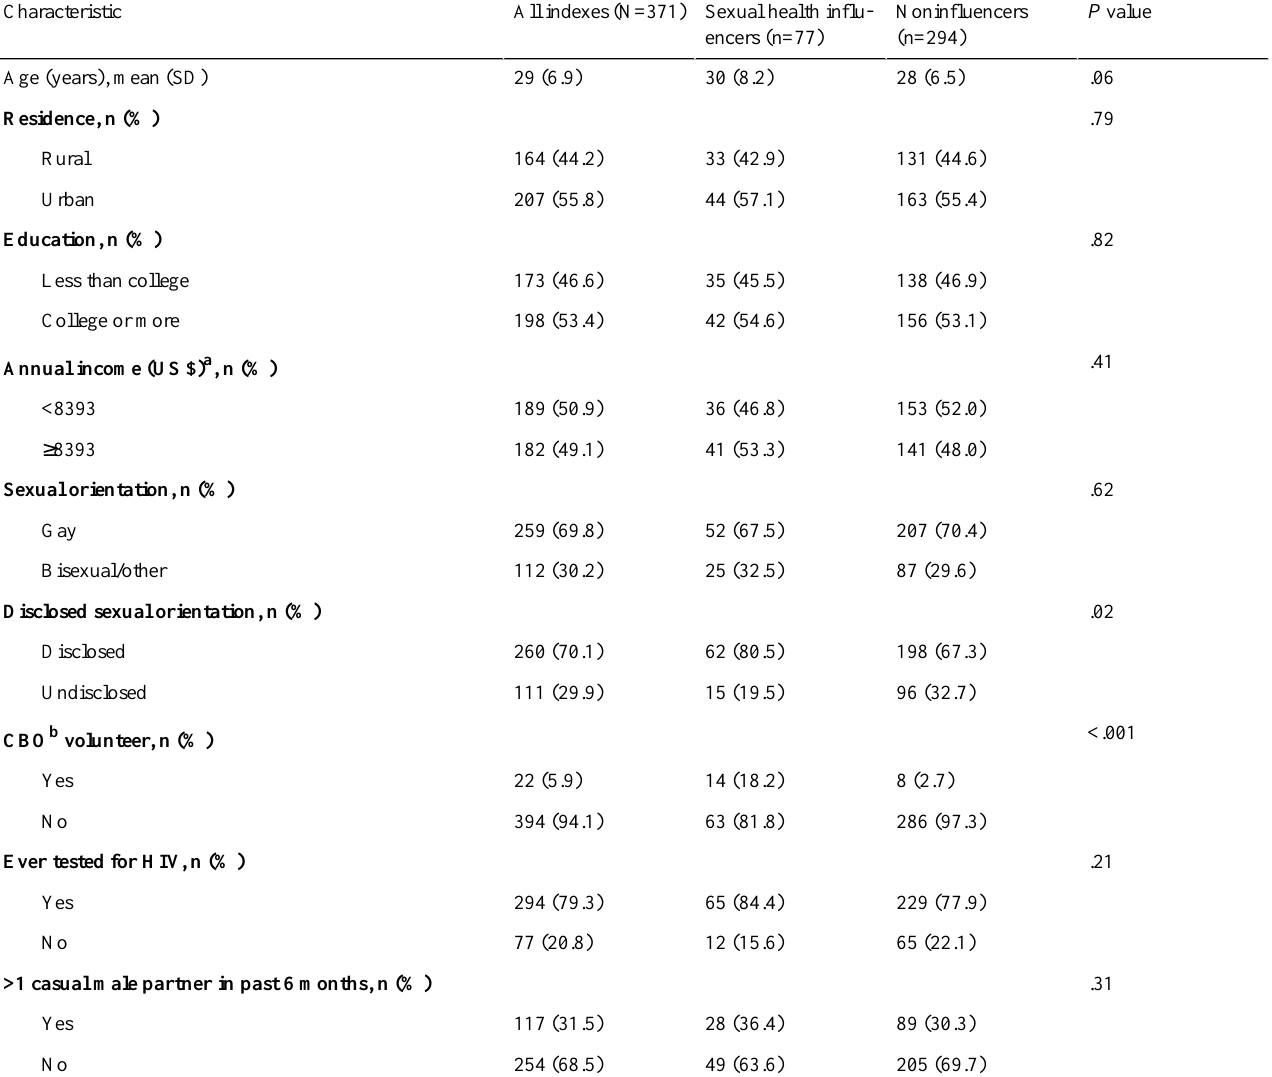
Table 1. Sociodemographic and health behavioral characteristics of the index participants in China, 2018-2019.